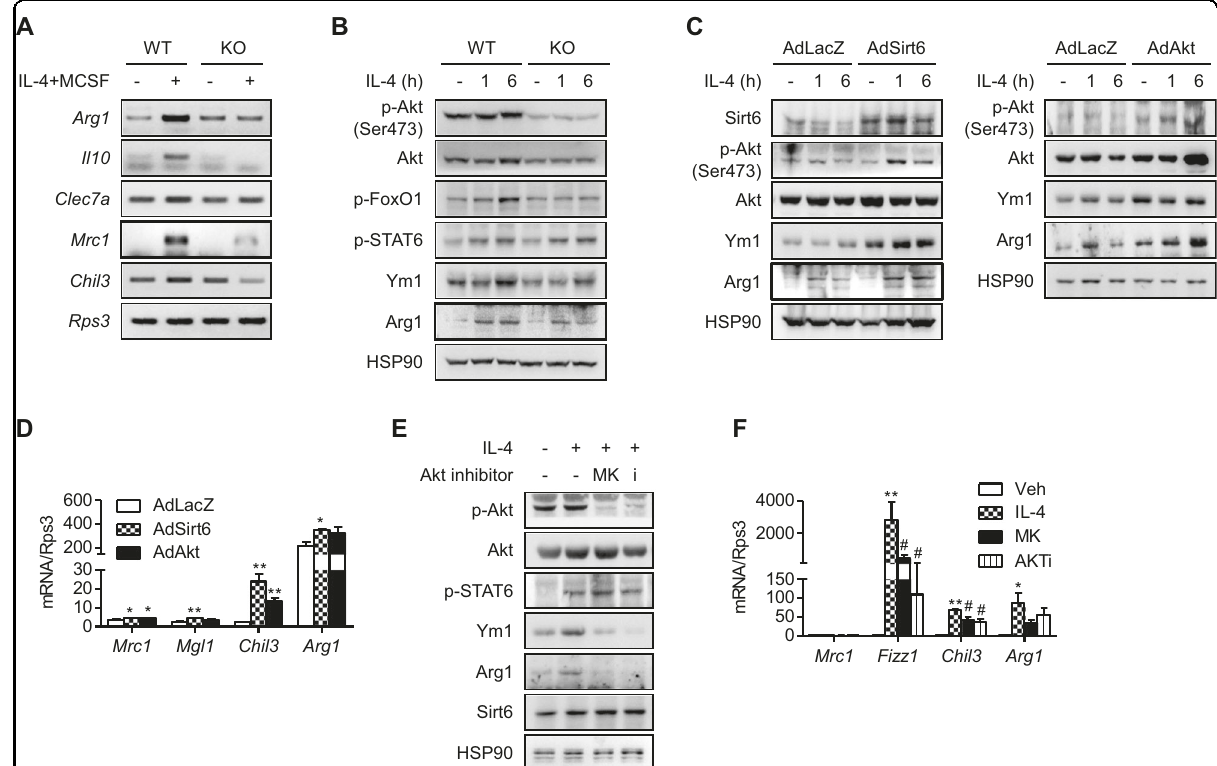
Fig. 7 Regulation of M2 polarization by Sirt6. a BMMs were treated with 10 ng/ml IL-4 and 10 ng/ml MCSF for 6 h, and the expression patterns of M2 marker genes were compared by RT-PCR. b BMMs were treated with 10 ng/ml IL-4 for the indicated periods, and then whole-cell extracts were generated and analyzed by Western blotting. c , d BMMs from mS6KO mice were transduced with an adenovirus expressing β -galactosidase (AdLacZ), Sirt6 (AdSirt6), or CA-Akt (AdAkt) at a multiplicity of infection (MOI) of 100 and treated with IL-4 for the indicated times. Protein and mRNA levels were analyzed. e , f BMMs from WT mice were treated with 10 ng/ml IL-4 and 10 ng/ml MCSF for 6 h with or without Akt inhibitors (8 μ M MK2206 and 10 μ M Akti), and then the protein levels in the whole cell extract and mRNA levels of M2 marker genes were determined. Values represent the mean ± SEM ( n = 3). * p < 0.05 and ** p < 0.01 vs. AdLacZ or Veh; # p < 0.05 vs. IL-4. Veh Vehicle, MK MK2206, i